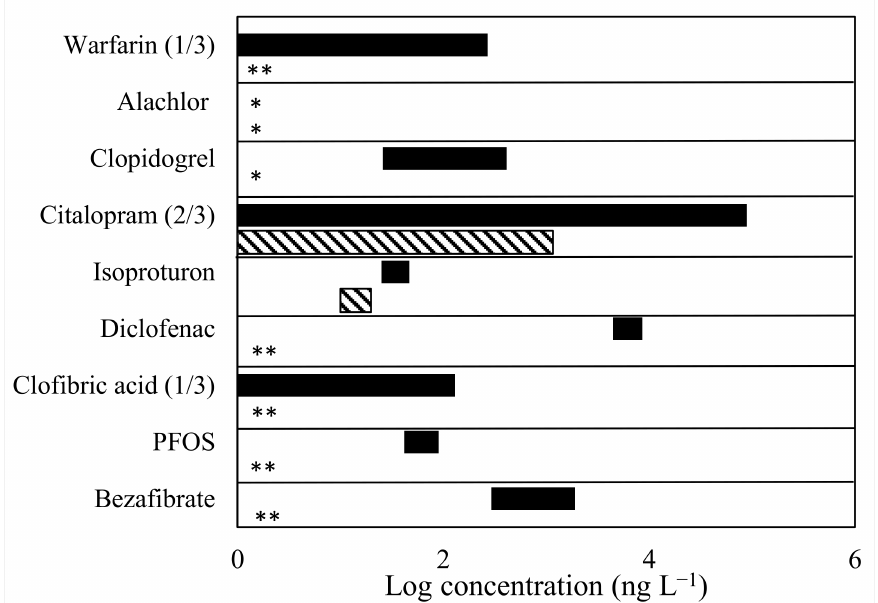
Figure 2. Logarithmic range of concentrations (ng L − 1 ) of the detected micropollutants in WW (black bar) and TWW 0 (striped bar) for samples with concentrations above LOQ. The frequency of occurrence was 100% (3 / 3) for all compounds, except when indicated in brackets after the compound name. * < LOQ and ** < LOD (compounds with concentrations < LOD before treatment are not shown in this figure for the sake of